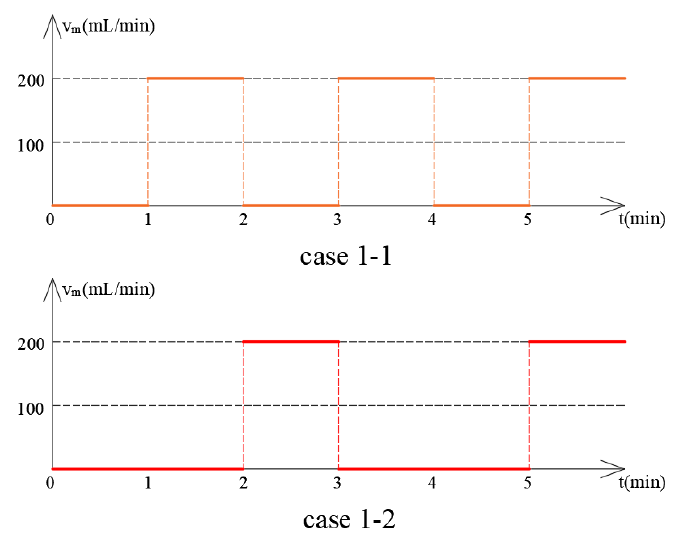
Figure 11. Control logic of intermittent flow.